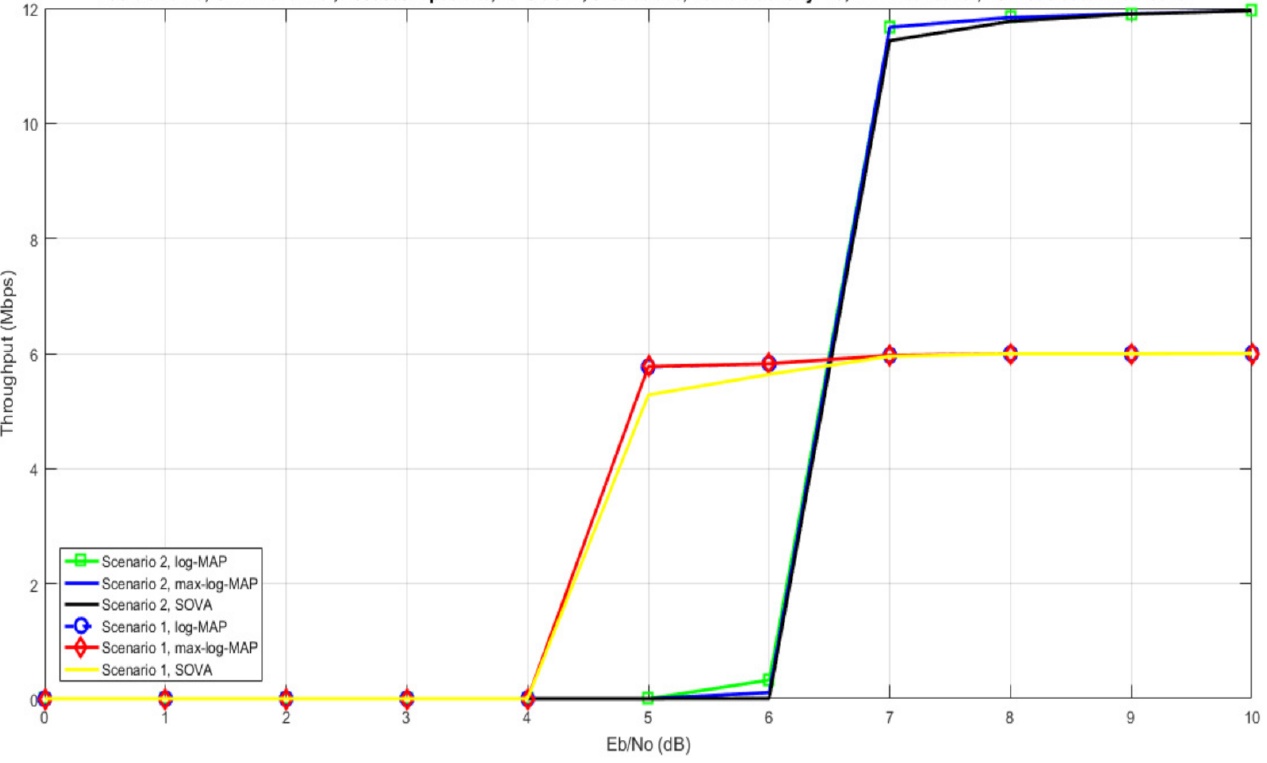
Figure 9. Throughput vs. SNR for scenarios 1 and 2 of Table 2, considering different decoding algorithms, 3 iterations, frame length of 256